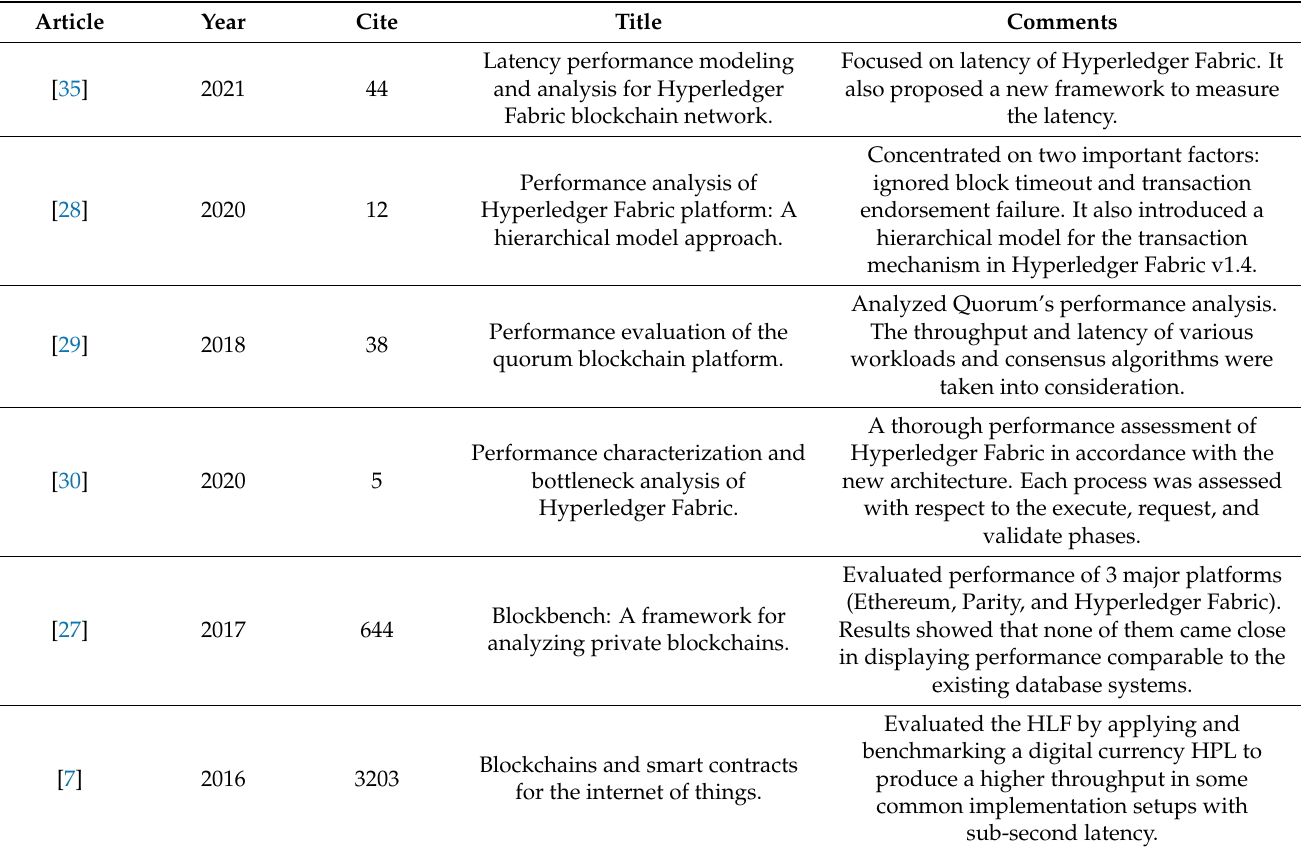
Table 1. Some recent experimental analysis of HLF and